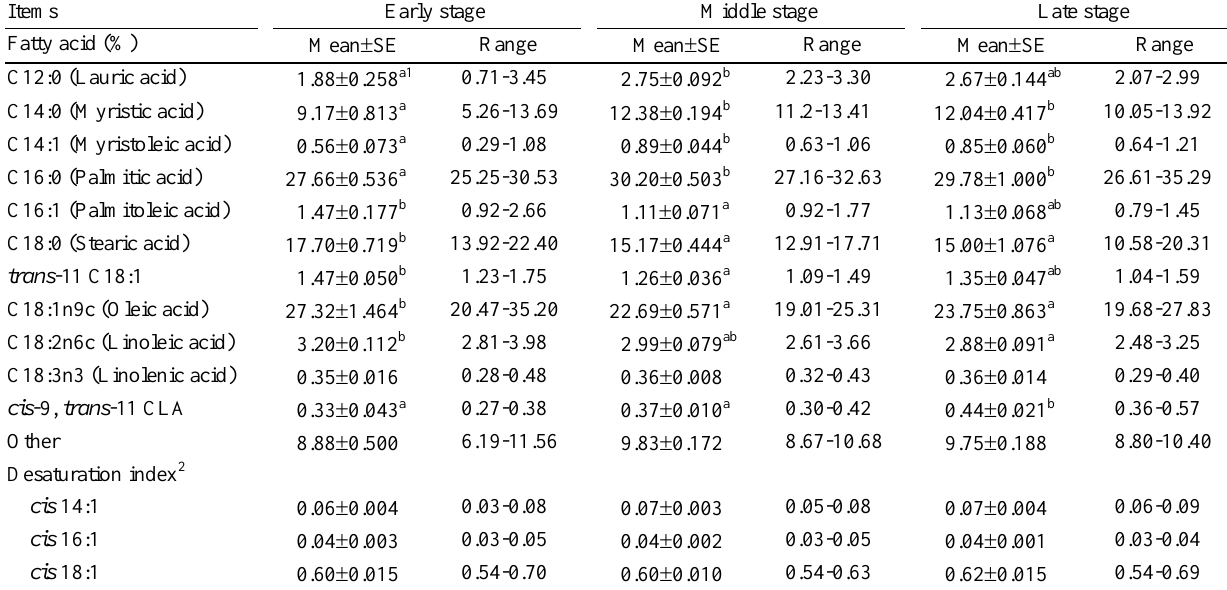
Table 4. Differences in major milk fatty acids (%) from dairy cows in Experiment 1 Early